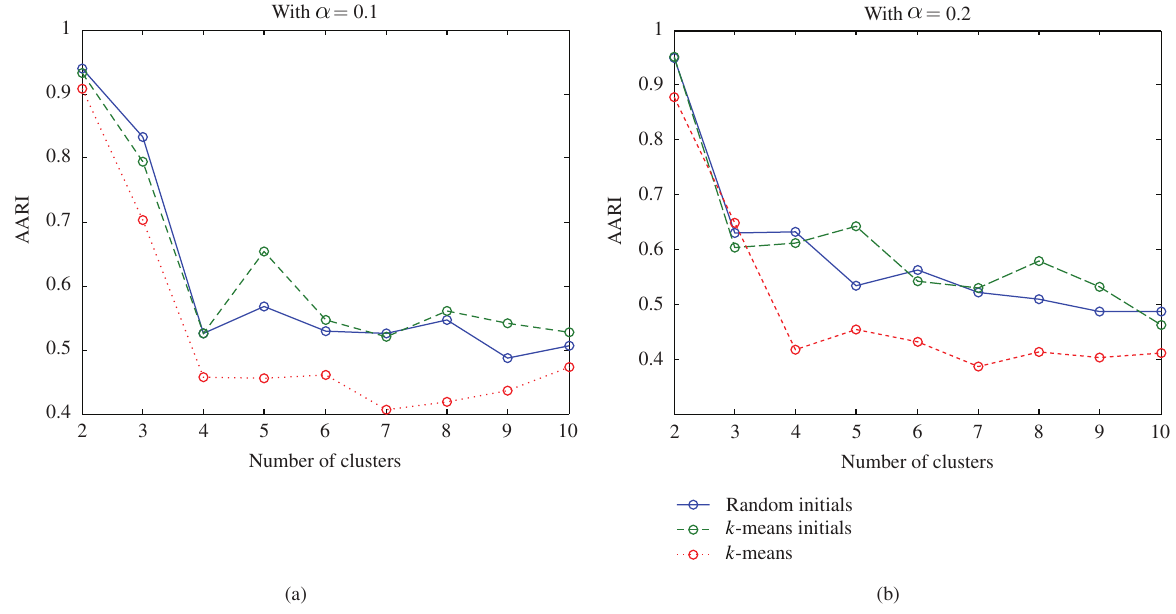
FIGURE 3: Plot of ARRI over different number of clusters for BAC after